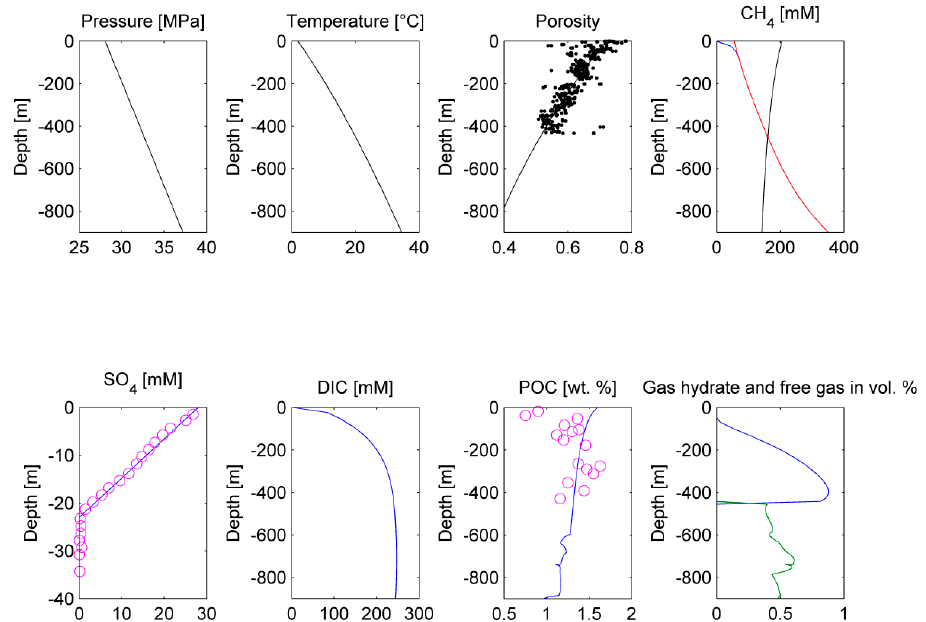
Figure 5. Modeling results of the Scenario 2b. Upper panel, from the left: Pressure, temperature, porosity, and dissolved CH 4 concentration plots. Porosity measurements [20] are depicted as black dots, the modeling solution is represented by the black line. On the CH 4 concentration plot, red line depicts the phase boundary between gas hydrate and dissolved methane, black line represents the phase boundary between free gas and dissolved methane, blue line states dissolved methane concentration. Gas hydrate and / or free gas formation occurs wherever dissolved methane concentration exceeds one of the solubility curves. Lower panel, from the left: SO 4 , DIC, POC, and gas hydrate / free gas concentration plots (in blue and green, respectively). On the SO 4 and POC concentration plot, measured values are presented as pink circles [20], whereas model predictions are shown as the blue lines.